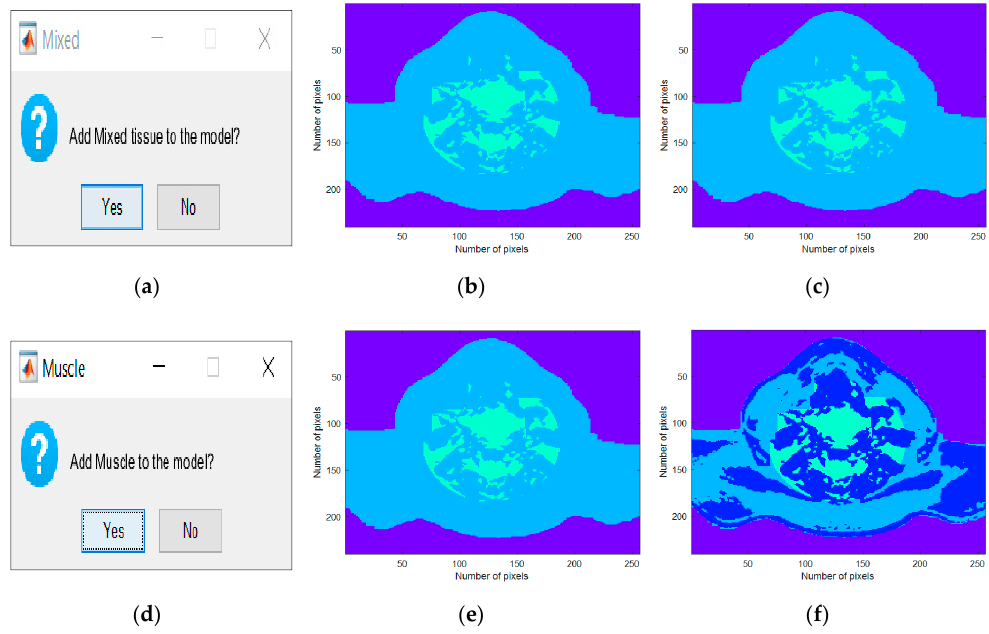
Figure 5. Interfaces created for the inclusion of the MRI-extracted tissues. (a) Generator interface which allows the users to include mixed tissue in the phantoms. (b,c) Axial slice of a 3D anthropomorphic head and neck phantom with fat and mixed tissues. (d) Interface which allows the user to insert muscle tissue in the phantom. (e) Axial slice of a 3D anthropomorphic head and neck phantom with muscle tissue. (f) Axial slice of a 3D anthropomorphic head and neck phantom which combines fat, mixed and muscle tissue.